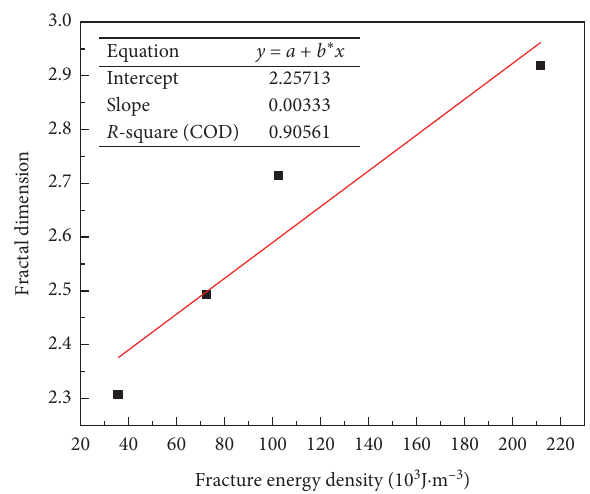
Figure 8: The relationship between fractal dimension and fracture energy density without confining